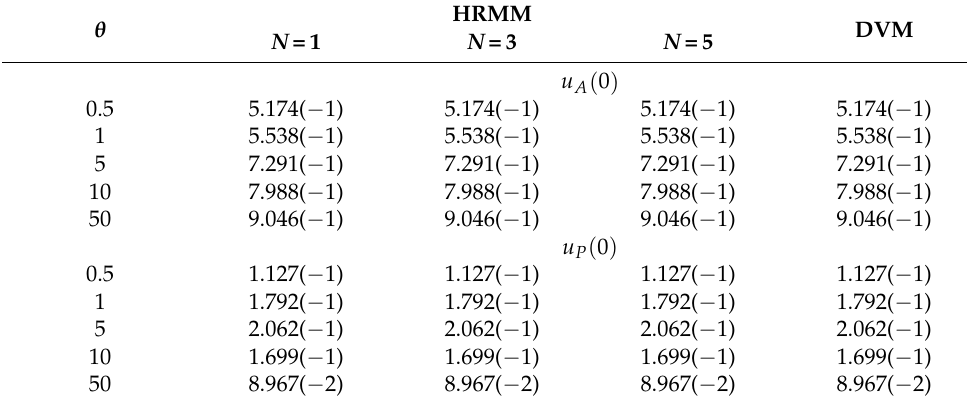
Table 1. Oscillatory Stokes flow; velocity amplitude and phase (rad) at the oscillating wall ( y = 0) for various values of θ based on the HRMM, with N = 1,3,5 and the DVM.